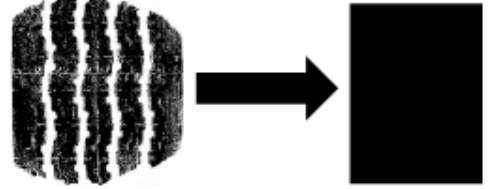
Figure 5. Schematic diagram of tire imprint.